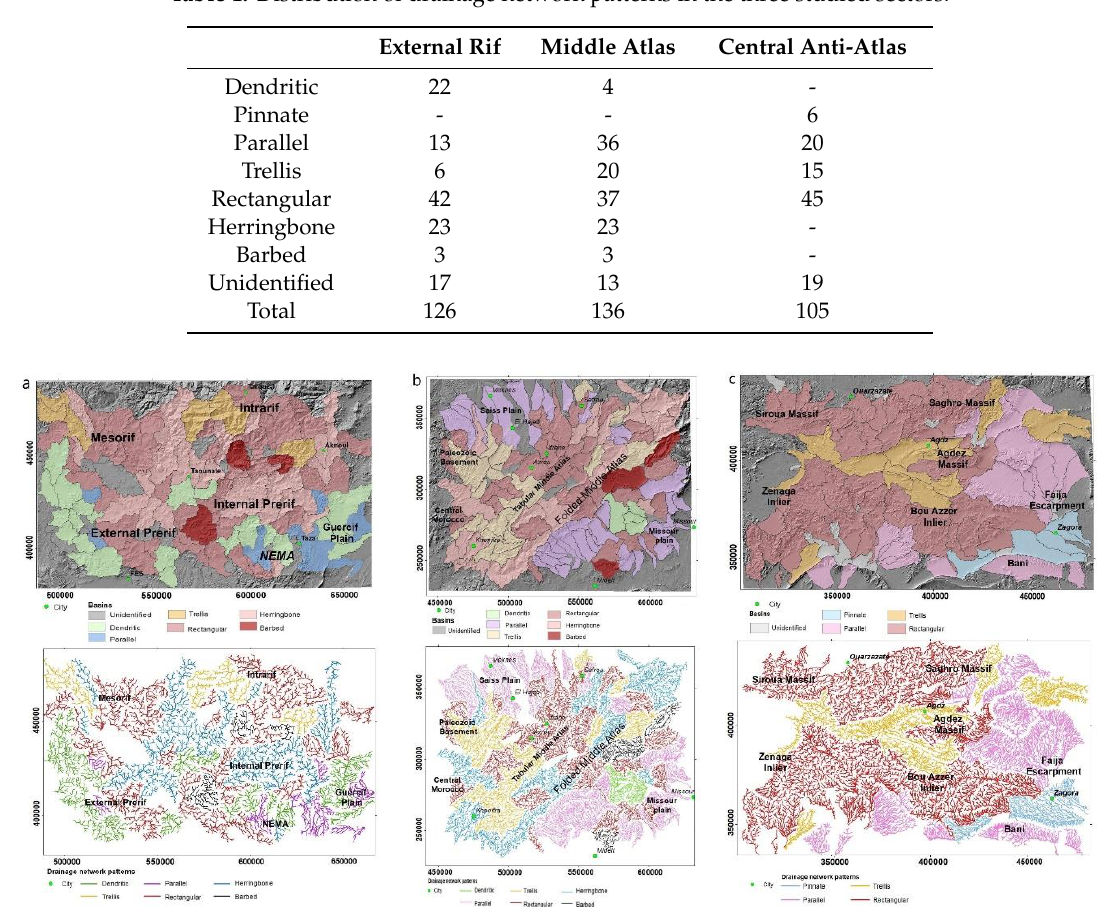
Table 1. Distribution of drainage network patterns in the three studied sectors.